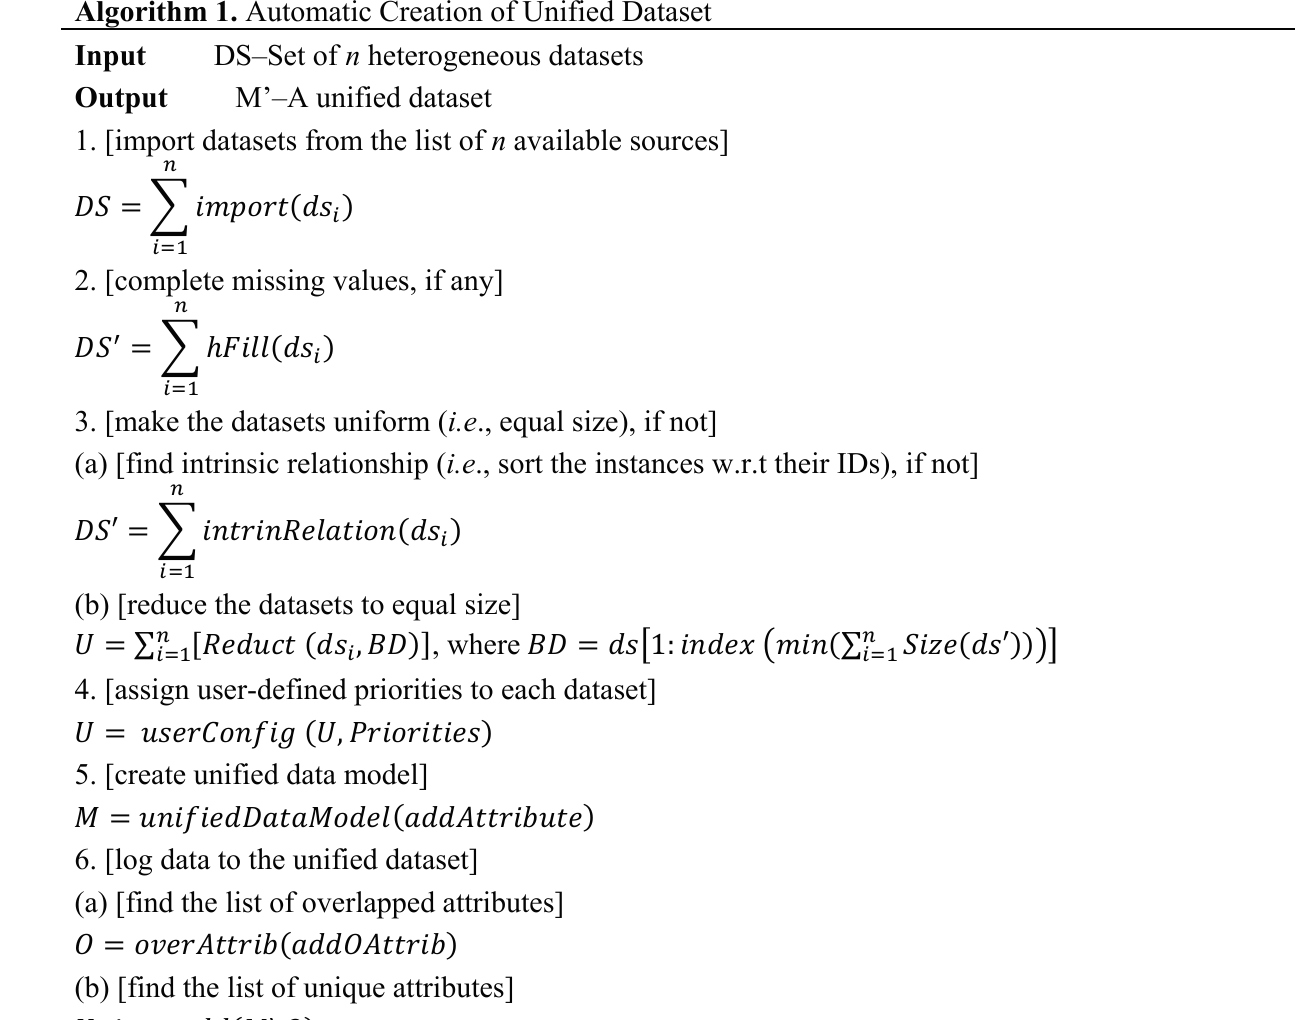
Algorithm 1. Automatic Creation of Unified